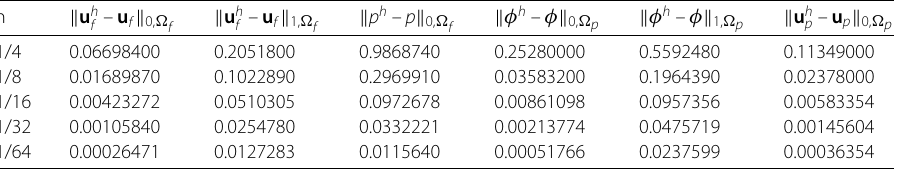
Table 1 Approximate error of the stabilized finite element scheme for test 1